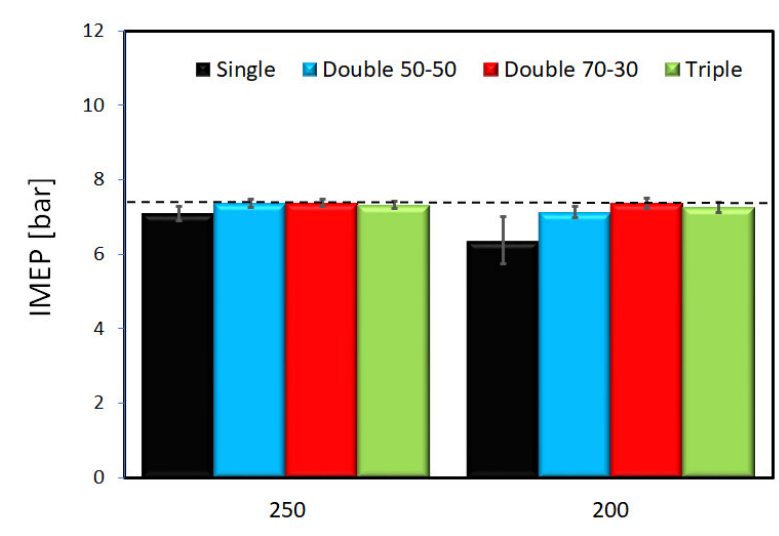
Figure 7 . Indicate mean effective pressure (IMEP) values for different split injection strategies at fixed SA (15 CAD BTDC) and engine speed (2000 rpm); second injection phasing set at 250 (left) and 200 (right) CAD BTDC.